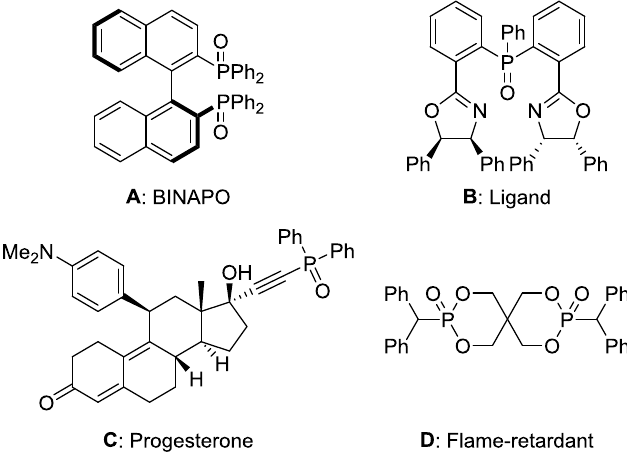
Figure 1. Some organophosphorus compounds.